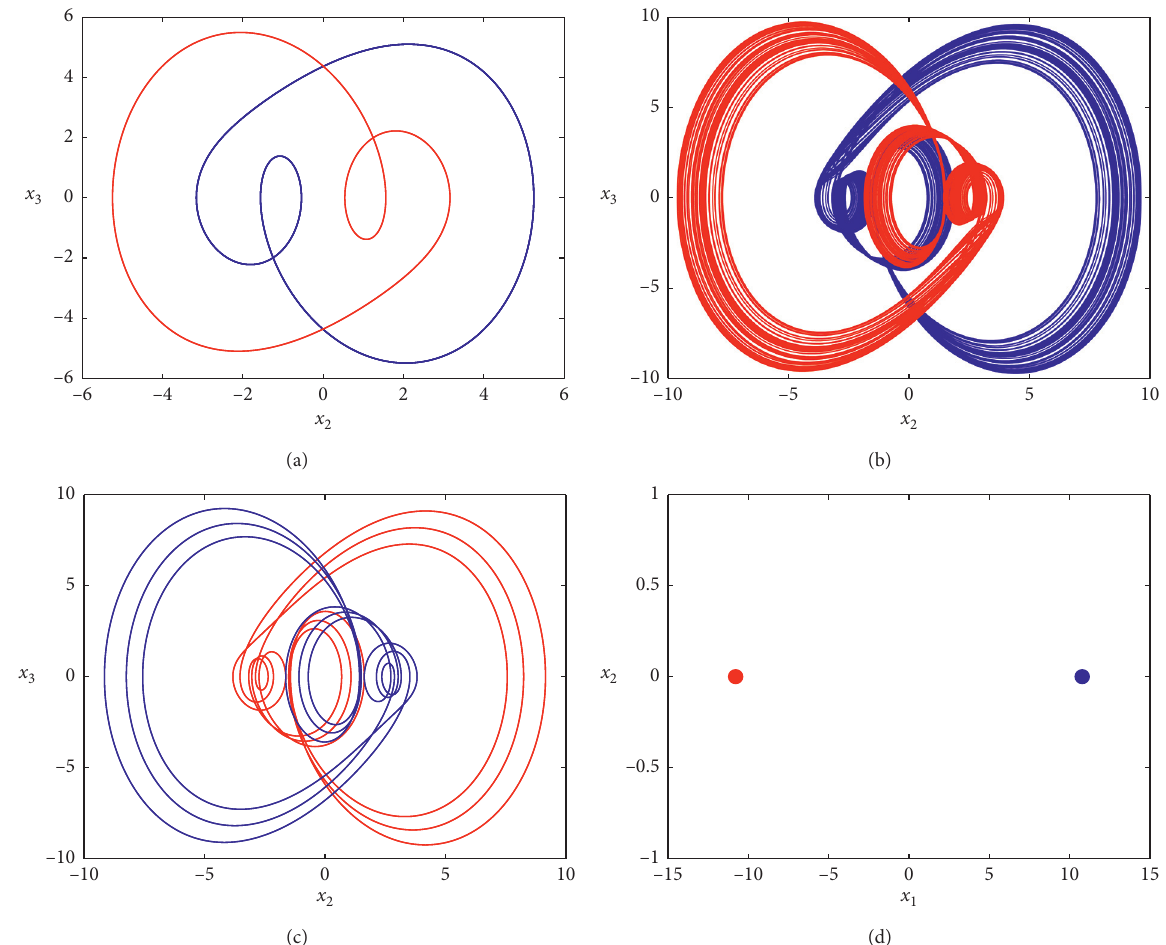
Figure 17: Coexistence of eight different attractors (a pair of symmetric period-2 limit cycle, a pair of symmetric chaotic attractors, and a pair of point attractors). The parameters are the same as those in Figure 16. Initial conditions are given in Table